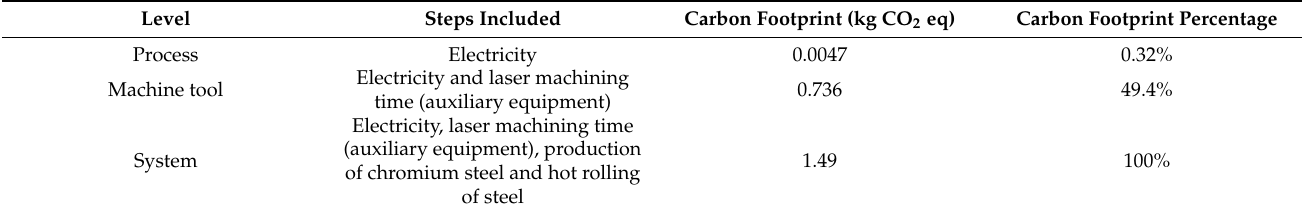
Figure 2. Allocation and values of carbon footprint per step in laser drilling, showing that the highest value of carbon footprint is coming from the laser machining time (auxiliary equipment consumption) (49%) and production of steel (48%). Table 3. Carbon footprint for laser drilling per level.